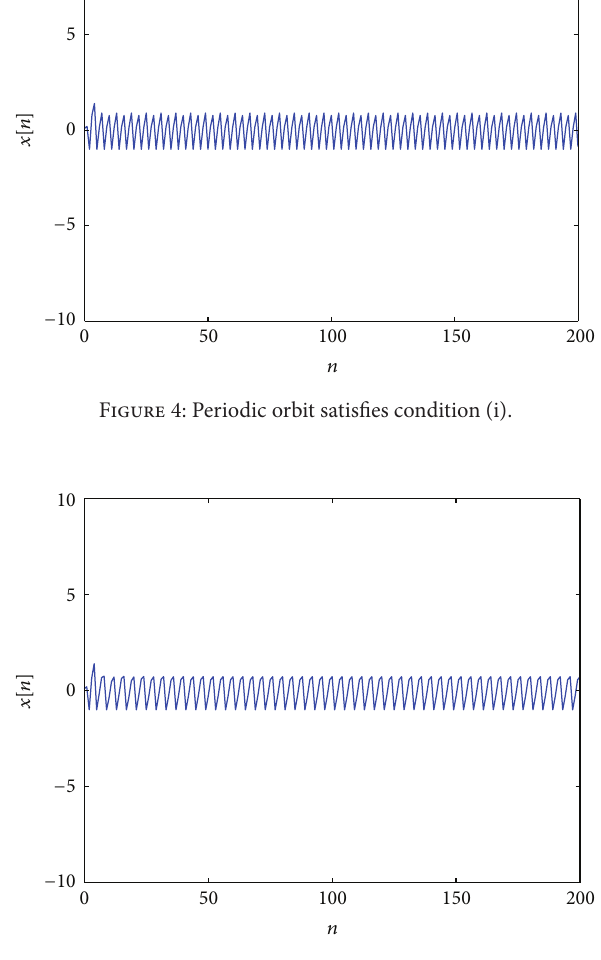
Figure 5: Periodic orbit satisfies condition